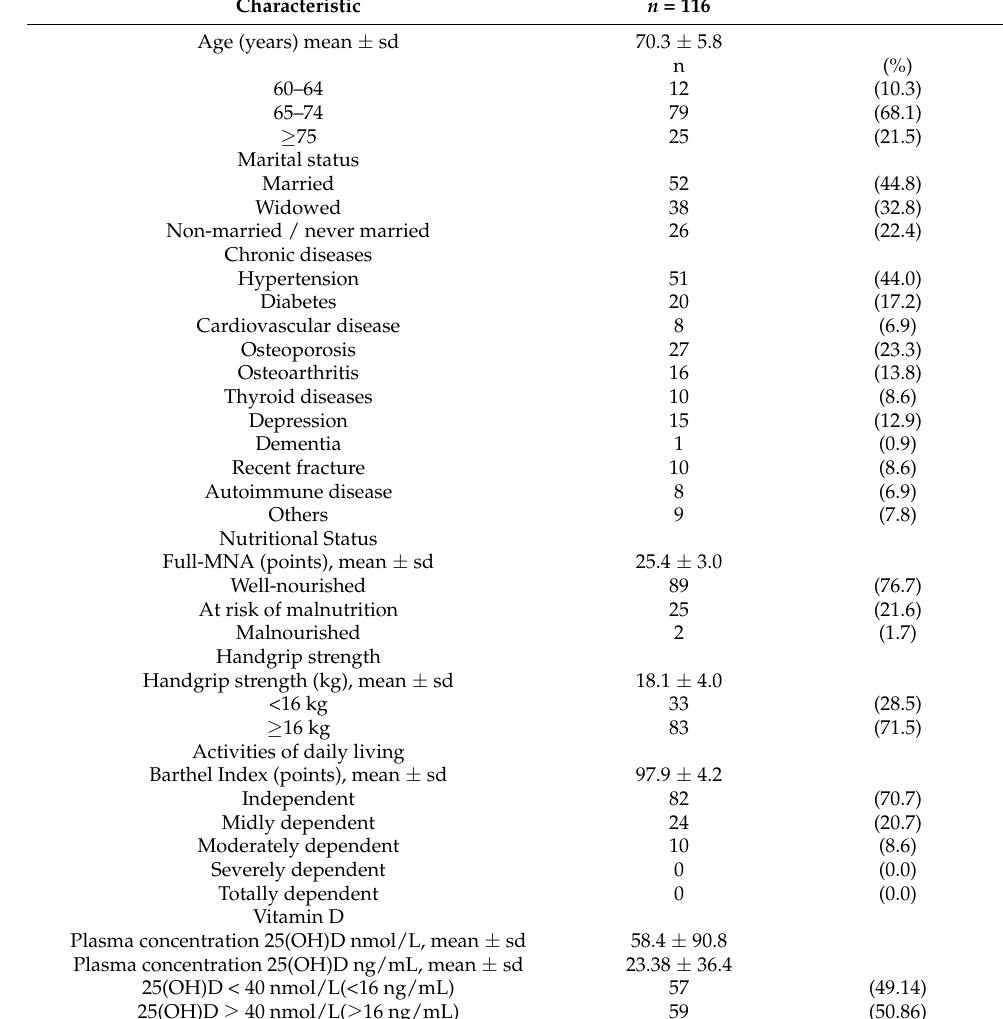
Table 1. Sociodemographic characteristics, medical conditions, nutritional status, activities of daily living score, and plasma 25(OH)D concentration of community dwelling Mexican older